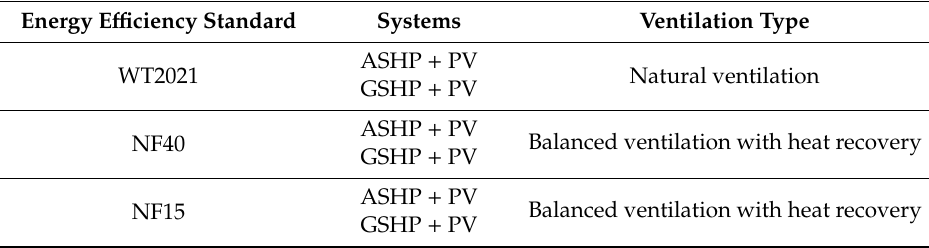
Table 1. Analysed variants